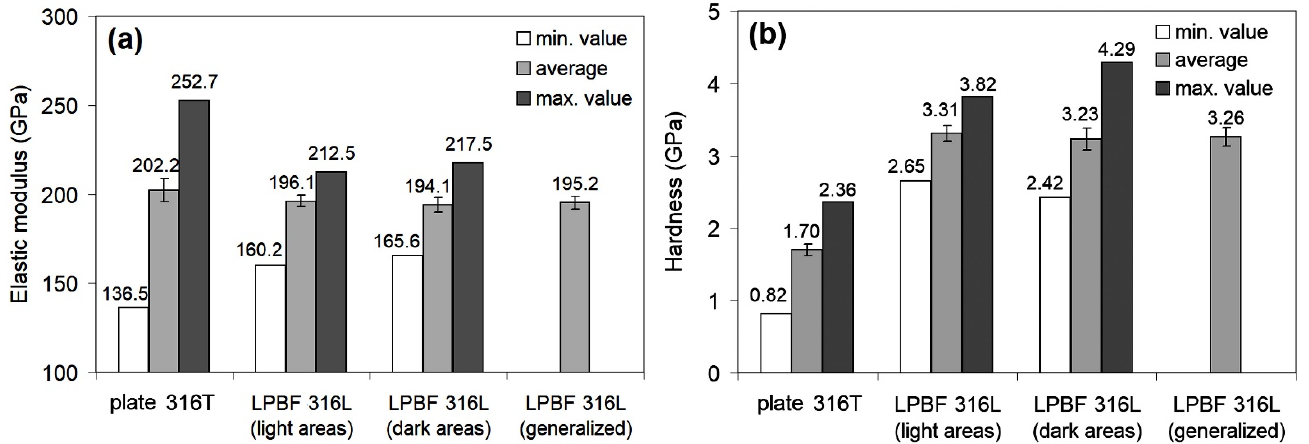
Figure 5. Nanoindentation results of the as-received plate 316T and LPBF 316L; ( a ) elastic modulus; ( b ) hardness. The E values for plate 316T scatter from 136.45 GPa to 252.70 GPa, with an average value of 202.21 ± 6.51 GPa. Accordingly, the hardness values are in the range of 0.823–2.36 GPa, with an average value of 1.704 ± 0.08 GPa. A typical load/displacement curve for plate 316T specimen is presented in Figure 6.